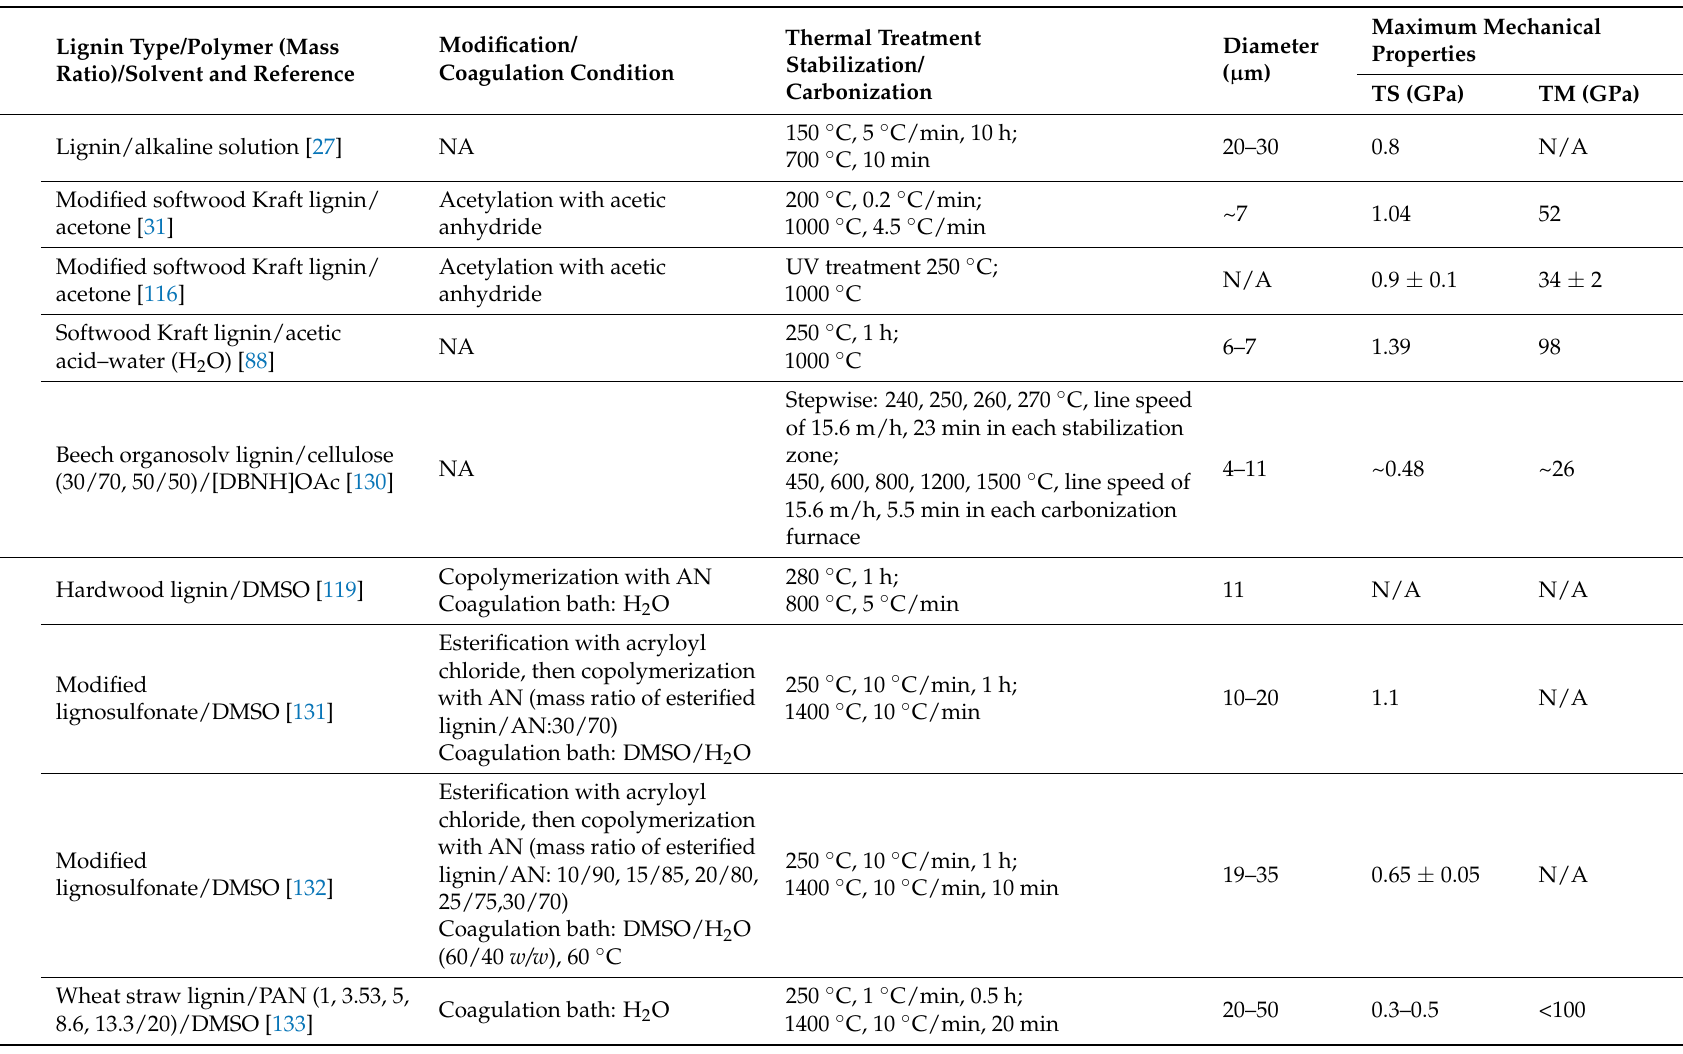
Table 2. Literature summary of solution-spun lignin-based carbon